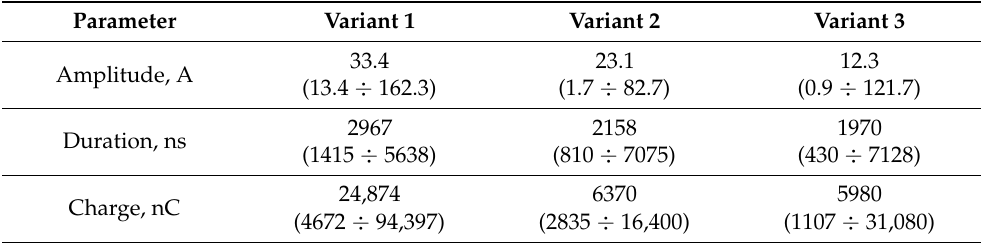
Table 3. Parameters of signals recorded on the model of a flat antenna under the model of the fairing with different variants of its lightning protection (average value,